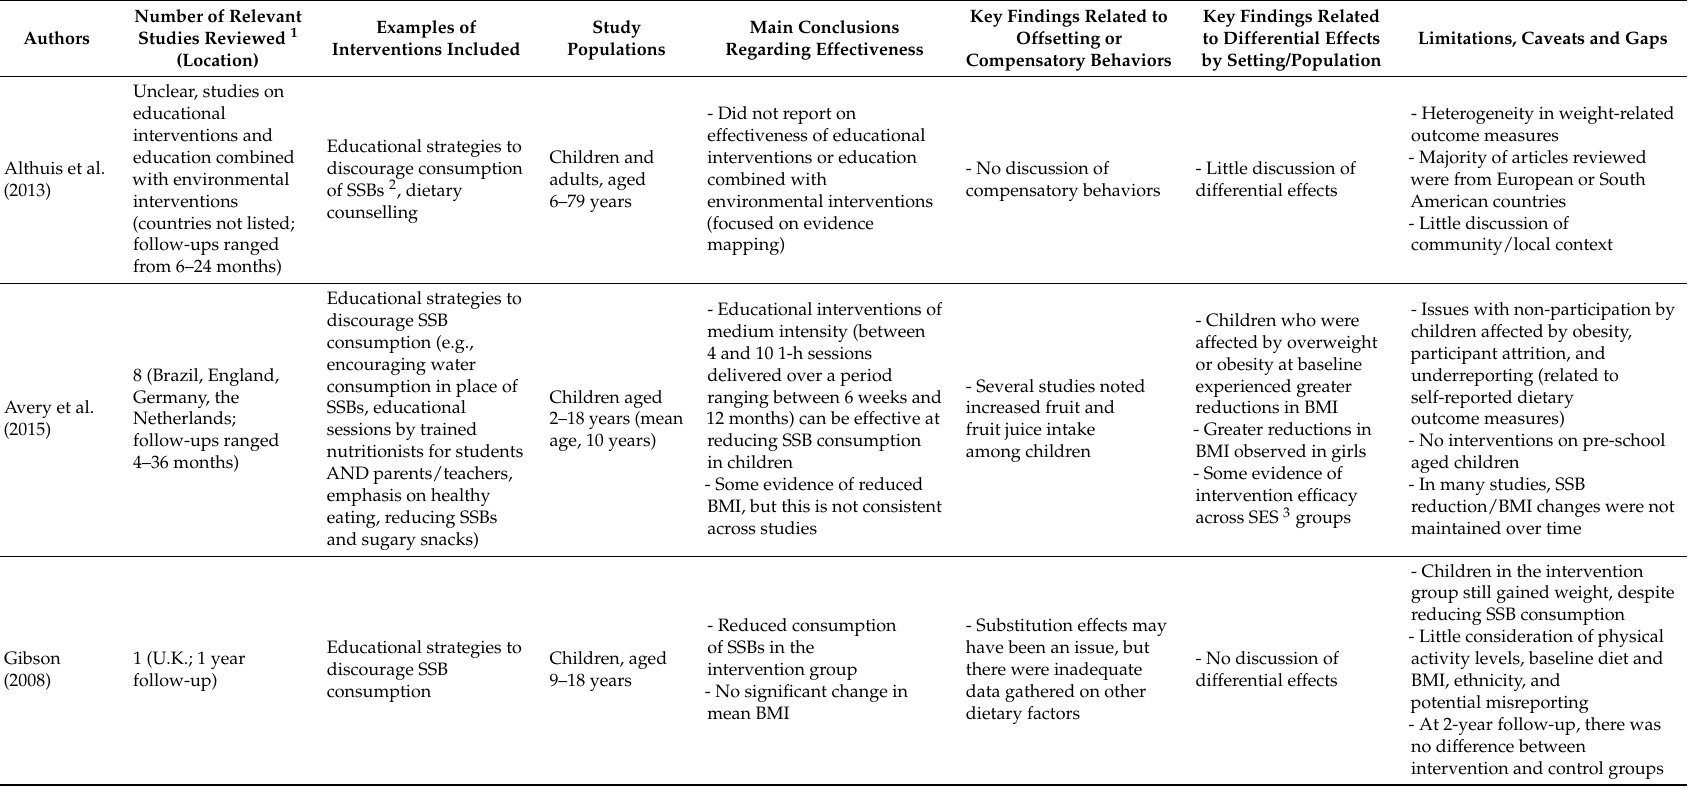
Table 4. Overview of evidence on health promotion and education interventions ( n = 7